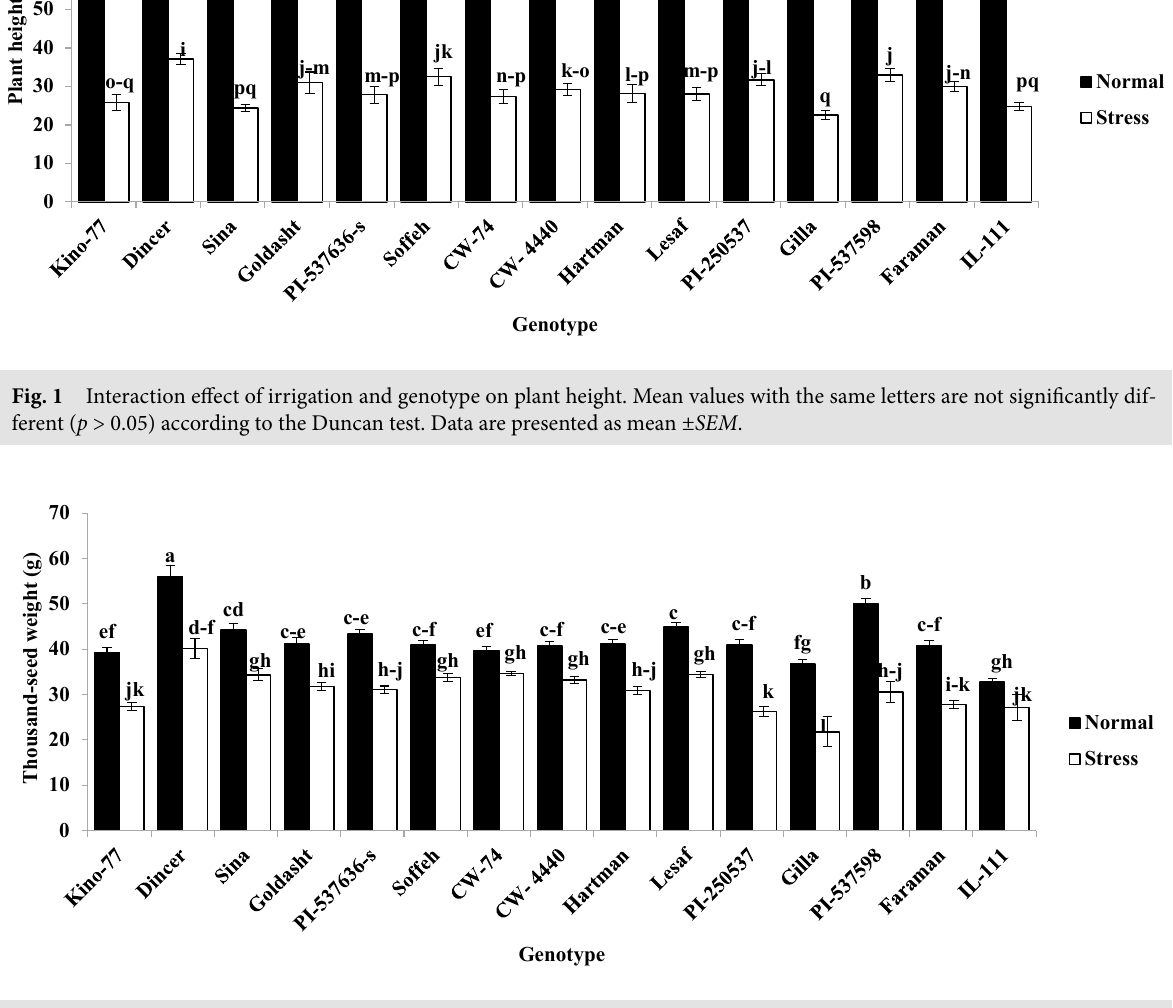
Fig. 2 Interaction effect of irrigation and genotype on 1,000-seed weight. Mean values with the same letters are not significantly different ( p > 0.05) according to the Duncan test. Data are presented as mean ± SEM